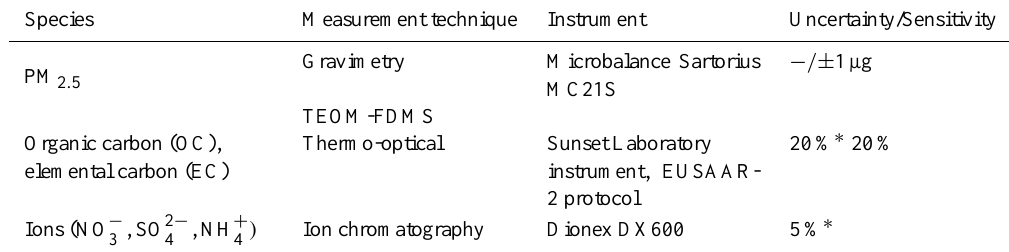
Table 1. Measurement techniques and instruments for PM 2 . 5 and each of its compounds.